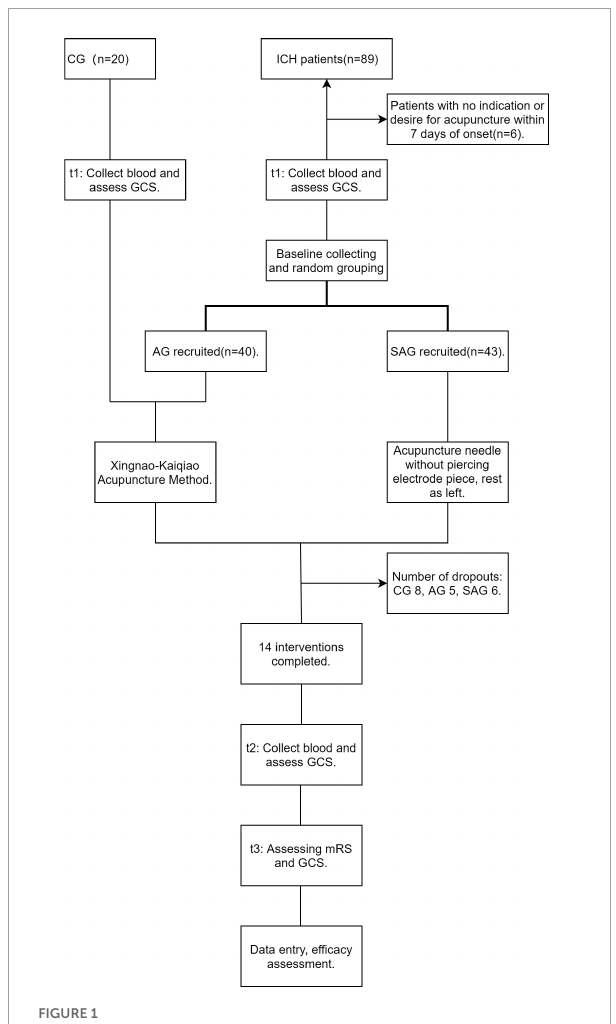
FIGURE1 Flow chart of subjects.